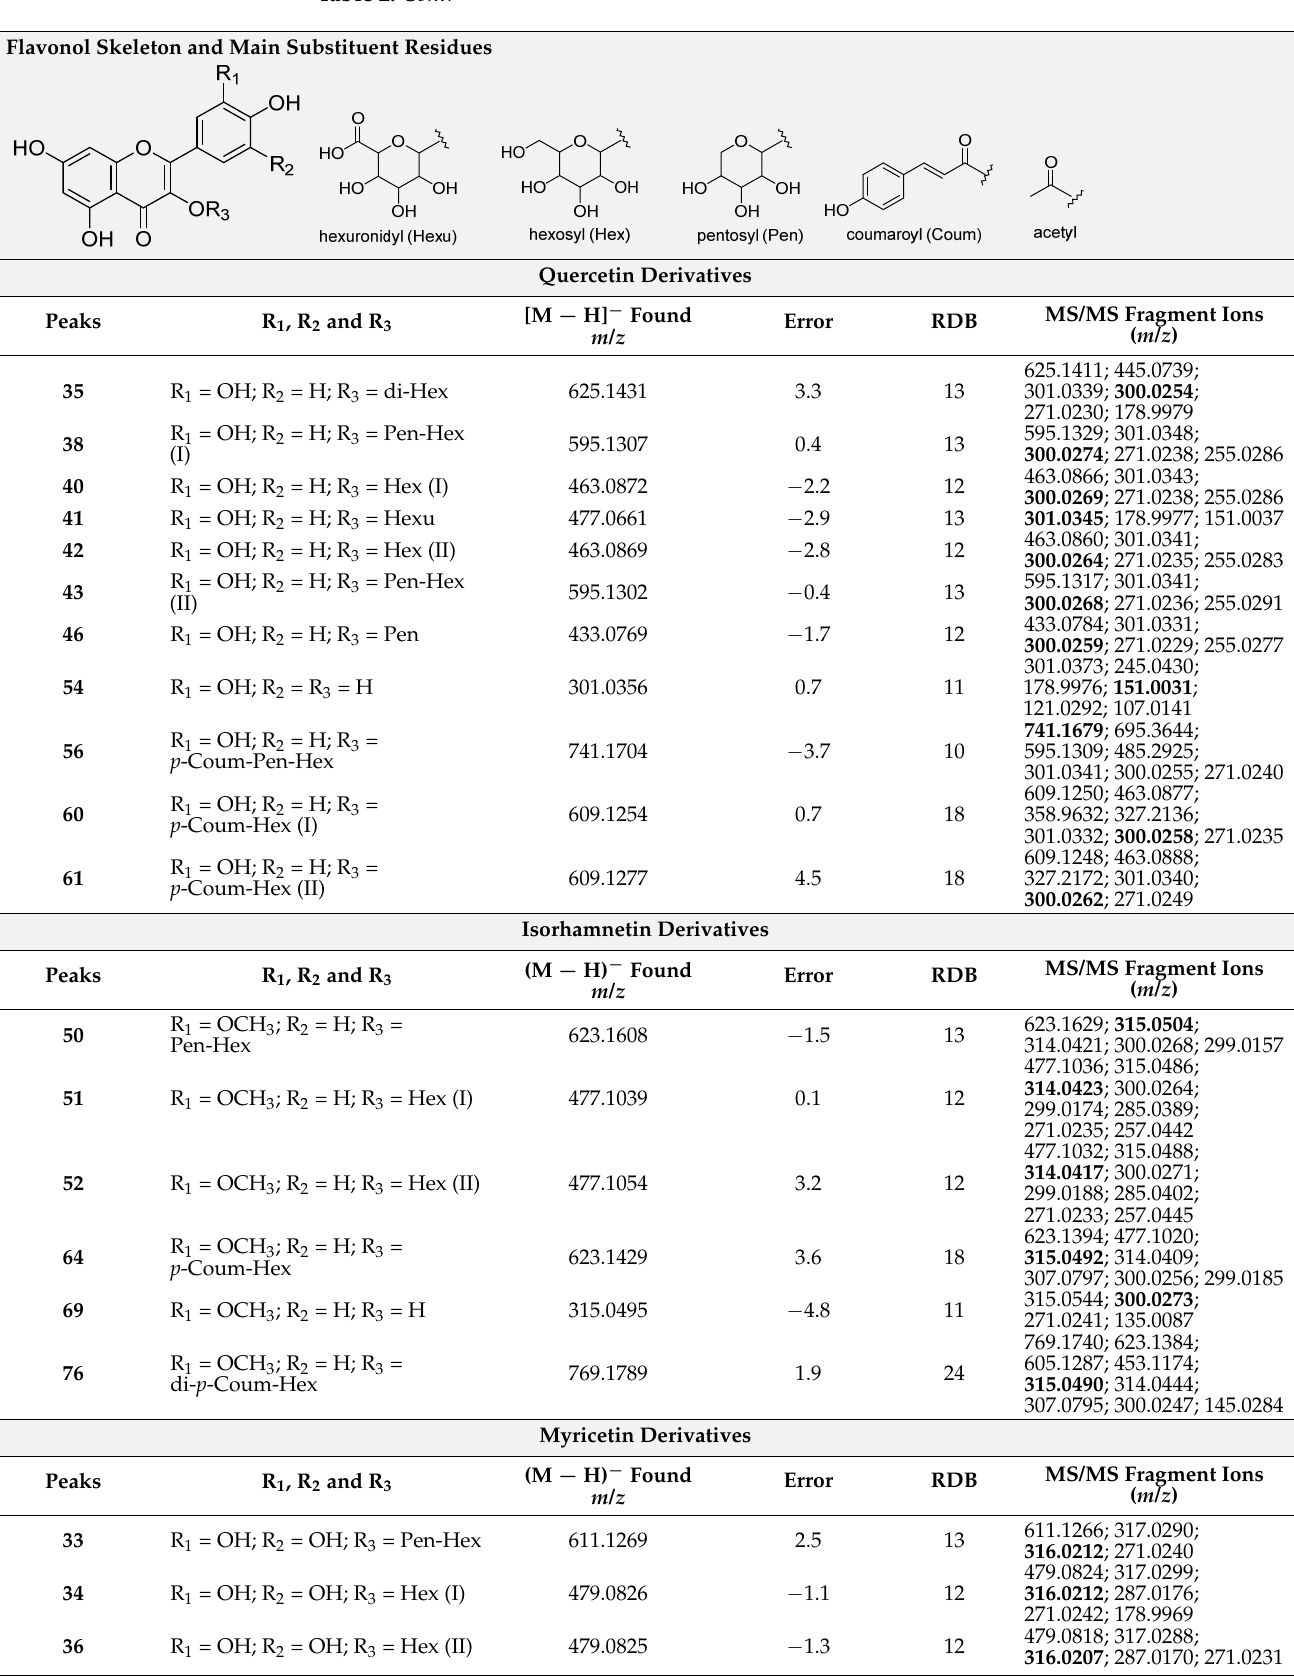
Table 2. Mono-, di- and acyl-glycosylated flavonols tentatively identified in oak leaf. RDB = ring double bond equivalent value. Base peak fragments are reported in bold.